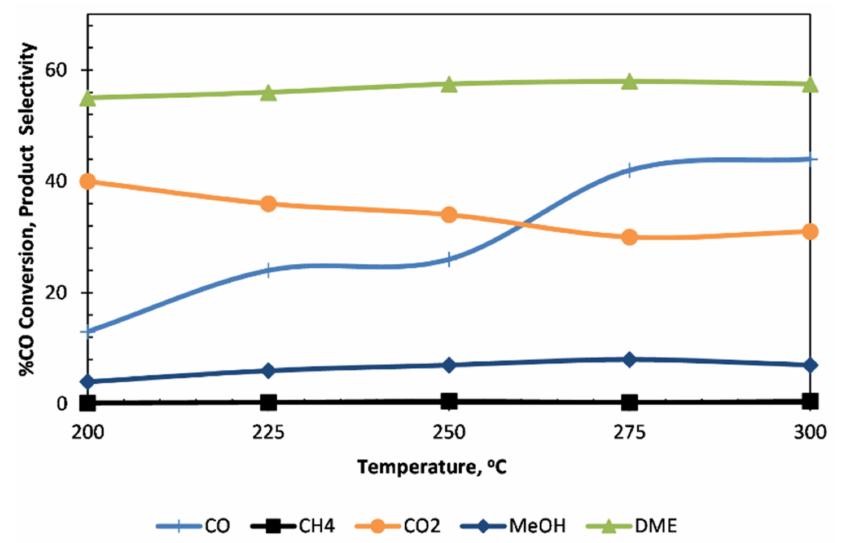
Figure 9. Effect of reaction temperature on CO conversion and product distribution (T = 200–300 ◦ C; P = 50 bar; CO/H 2 :1/1 as feed